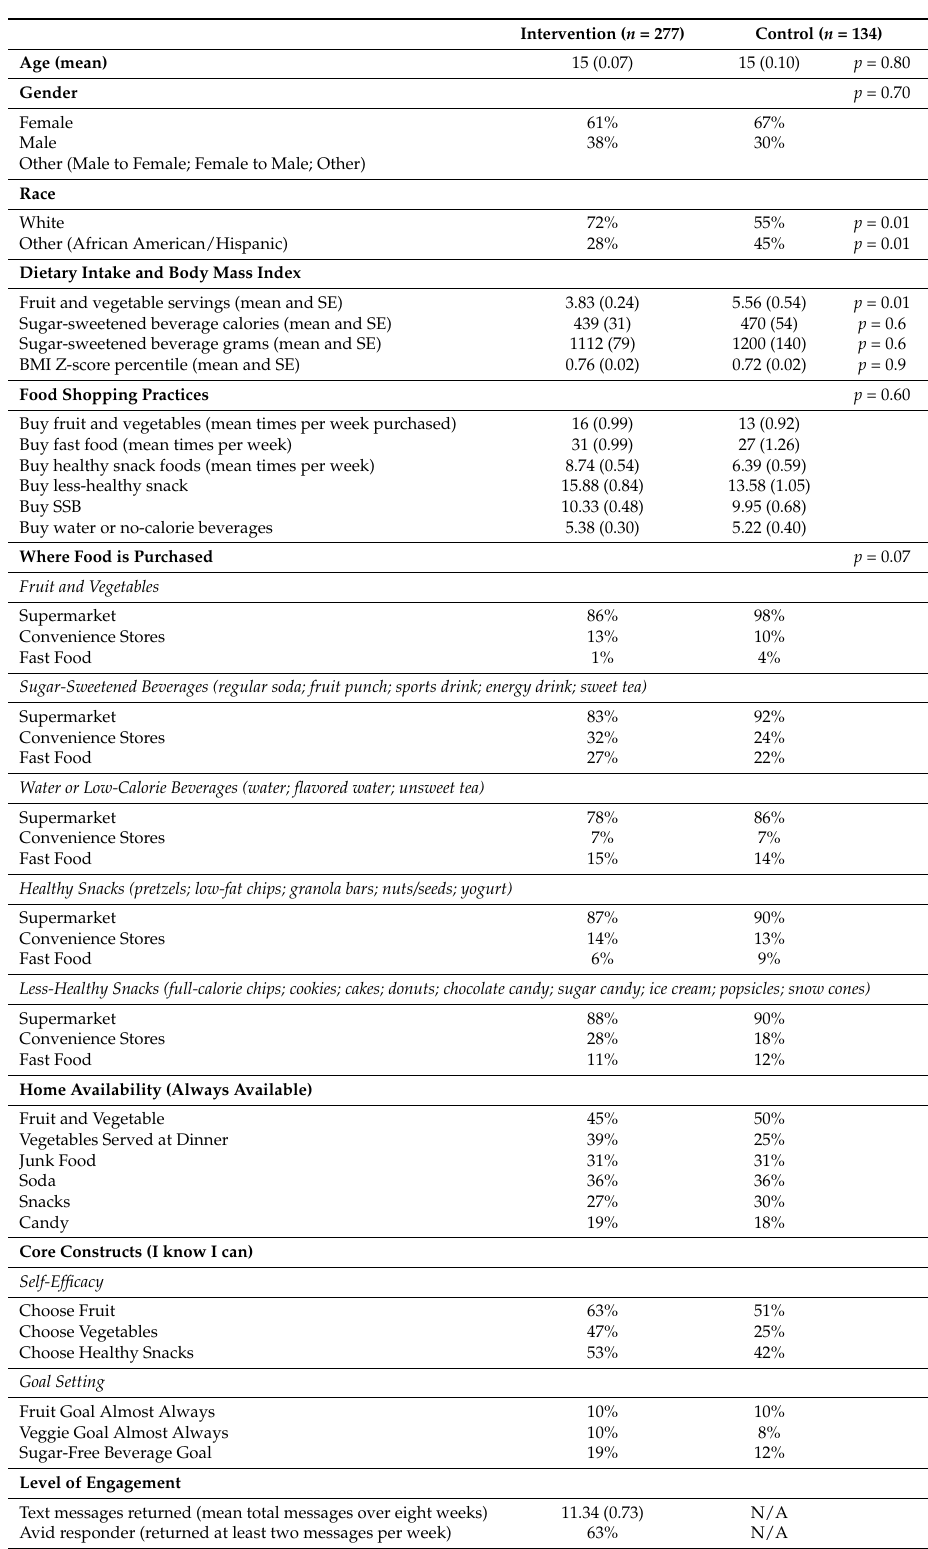
Table 1. Demographics baseline characteristics of intervention and control participants ( n =